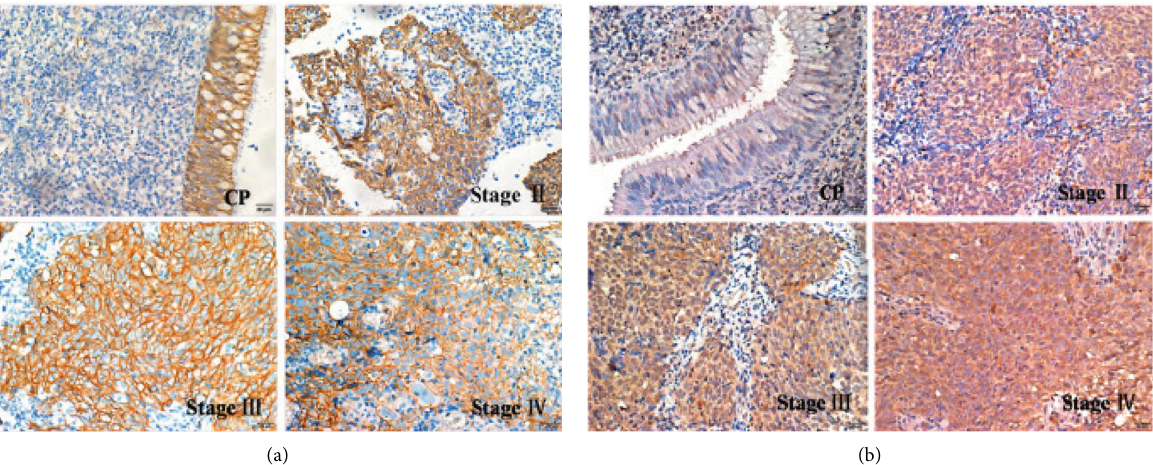
Figure 4: β -Catenin and MMP7 expressions in NPC and CP tissues detected by the immunohistochemistry method. (a) Representative images of β -catenin expression (brown-yellow or tan staining) in CP tissue or NPC tissues in stages II, III, and IV (magnification 200 × ). (b) Representative images of MMP7 expression (brown-yellow or tan staining) in CP tissue or NPC tissues in stages II, III, and IV (magnification 200 × ). CP, chronic pharyngitis; NPC, nasopharyngeal